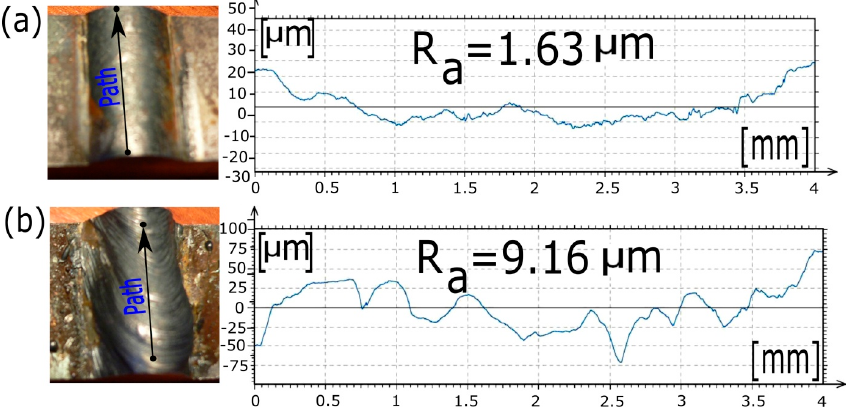
Figure 6. Roughness profile obtained and paths that the portable roughness tester probes followed to determine the roughness. ( a ) Low values of roughness obtained and ( b ) high values of roughness obtained.